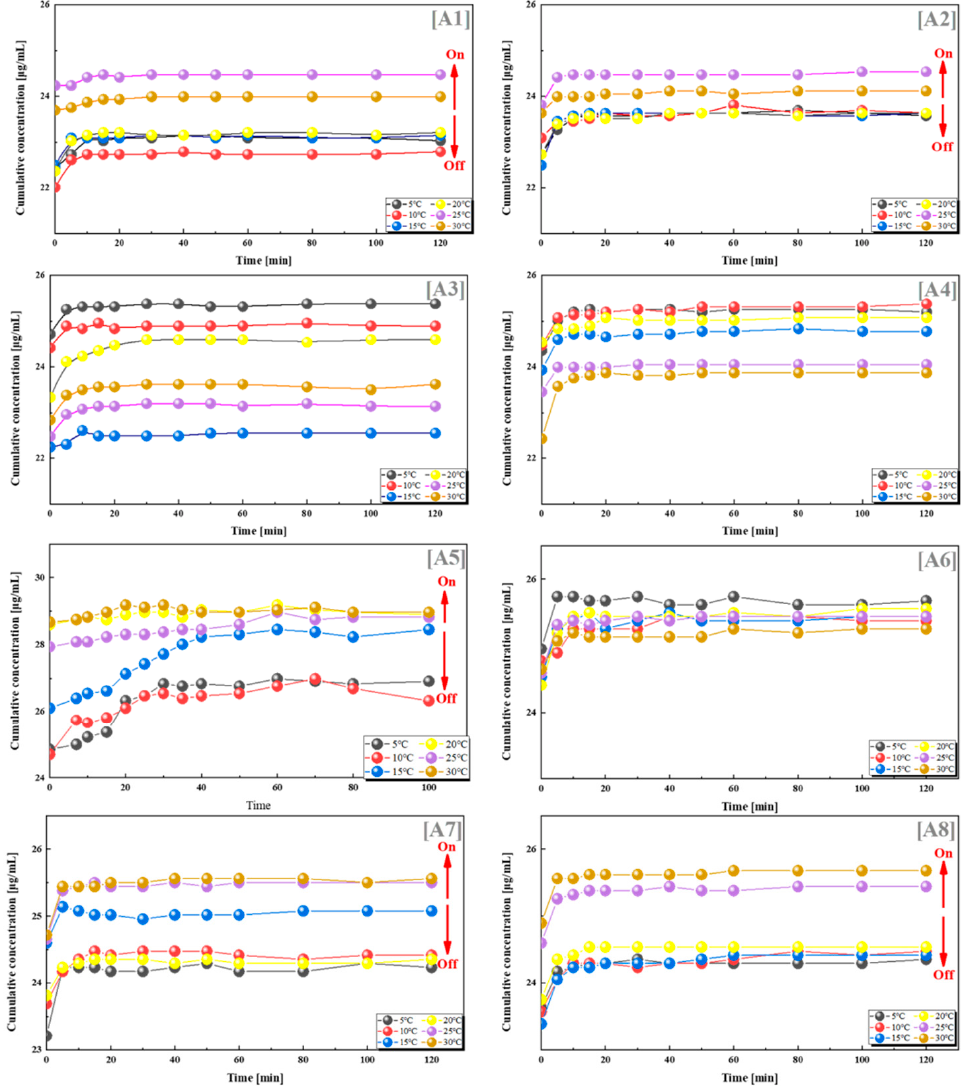
Figure 3. VB12 release from systems with different combinations of grafting rates at different temperatures. ( A1 ) 12–9%; ( A2 ) 12–15%; ( A3 ) 12–21%; ( A4 ) 12–25%; ( A5 ) 13–14%; ( A6 ) 17–9%; ( A7 ) 17–21%; ( A8 ) 17–25%. All the above combinations are for PES-g-PAAM microcapsules and PES-g-PAAC microcapsules with different grafting rates.